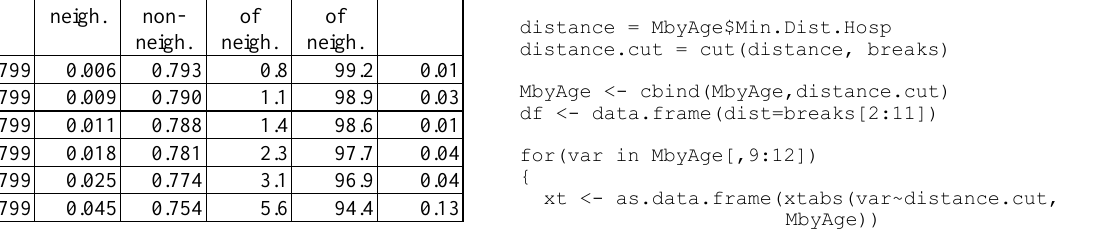
Table 1. Sensitivity analysis of the Gini coefficient for SAM